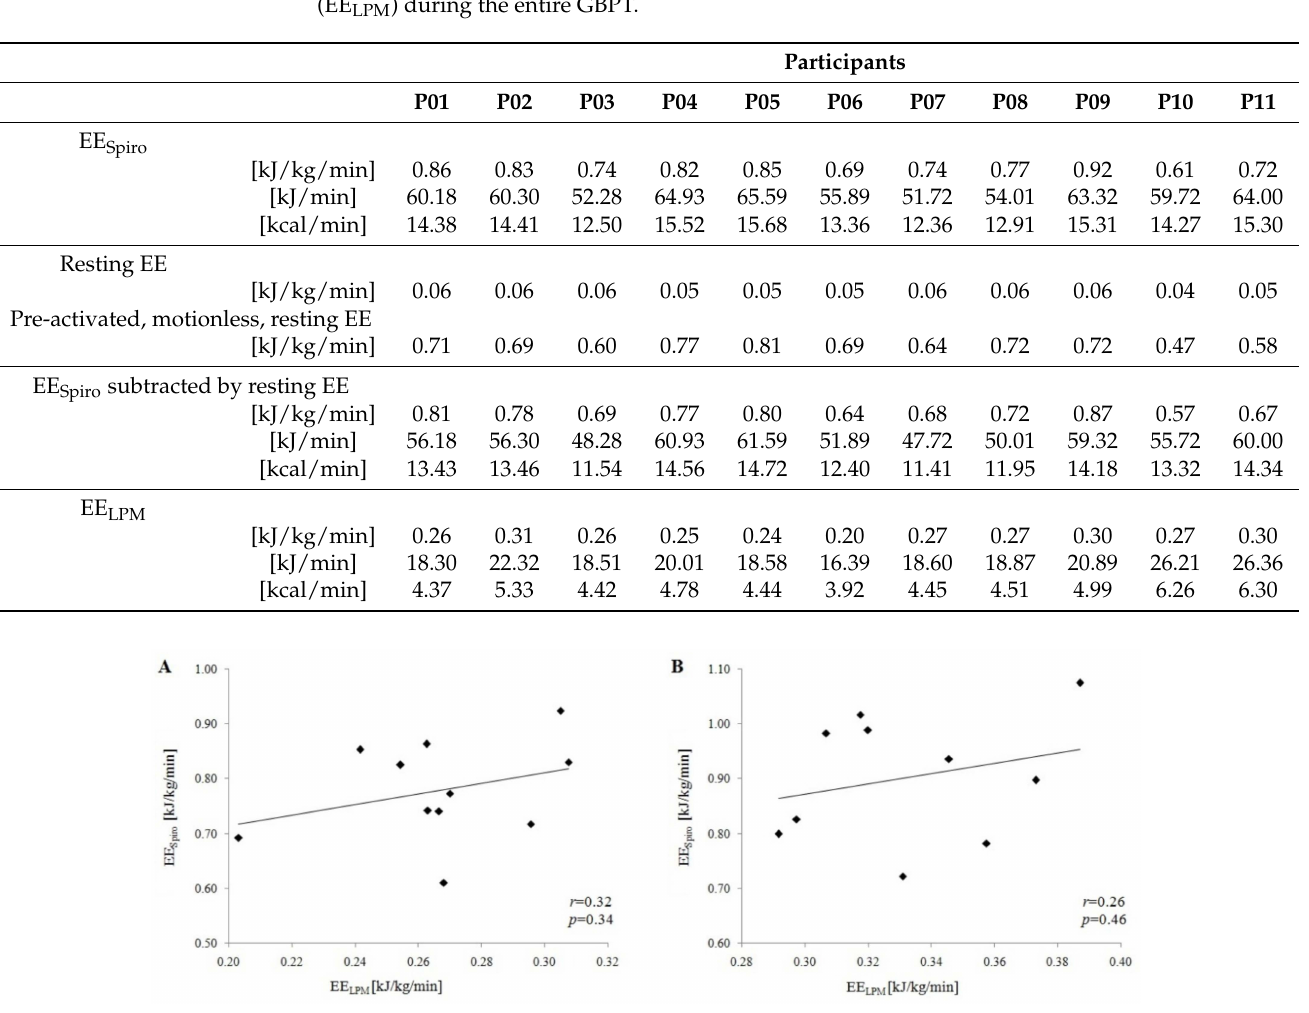
Figure 2. Correlation coefficient( r ) and significance (p ) between energy expenditure via spiroergome- try (EE Spiro ) and via local position measurement system (EE LPM ) for the entire test ( A ) and heat #6 as an example for the most intensive heat ( B